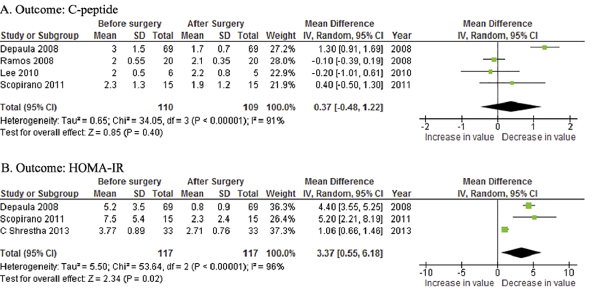
Fig 5. Forest plotsof the effects of metabolic surgery on: (A) C-peptide and (B) HOMA-IR. CI = confidence interval;HOMA-IR = homeostasis model assessment of insulin resistance; IV = inverse variance; SD = standard